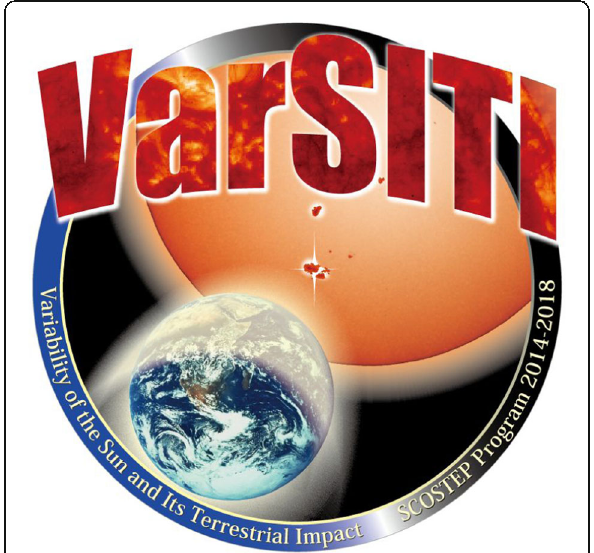
Fig. 17 VarSITI logo designed by Ms. Kadowaki of STEL, Nagoya